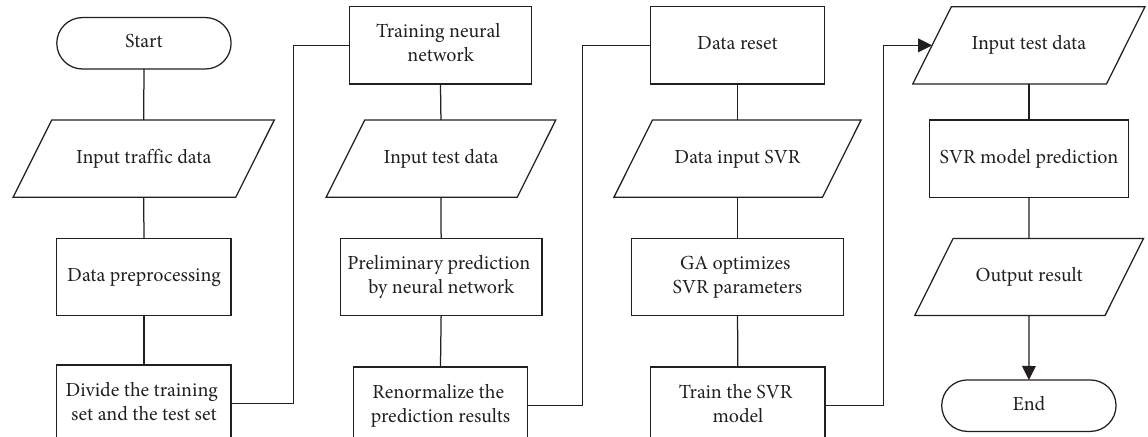
Figure 18: LSTM-GA SVR prediction process.